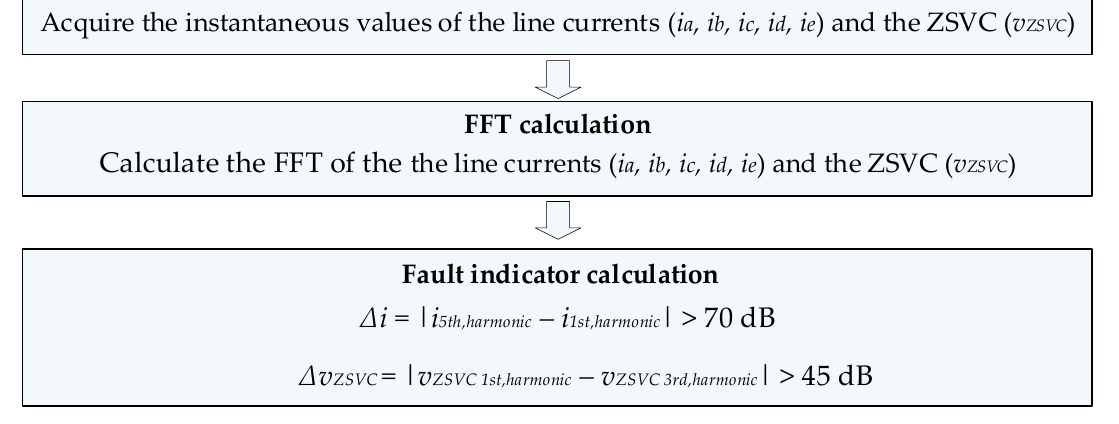
Figure 8. Proposed diagnosis method based on the calculation of two fault indicators.